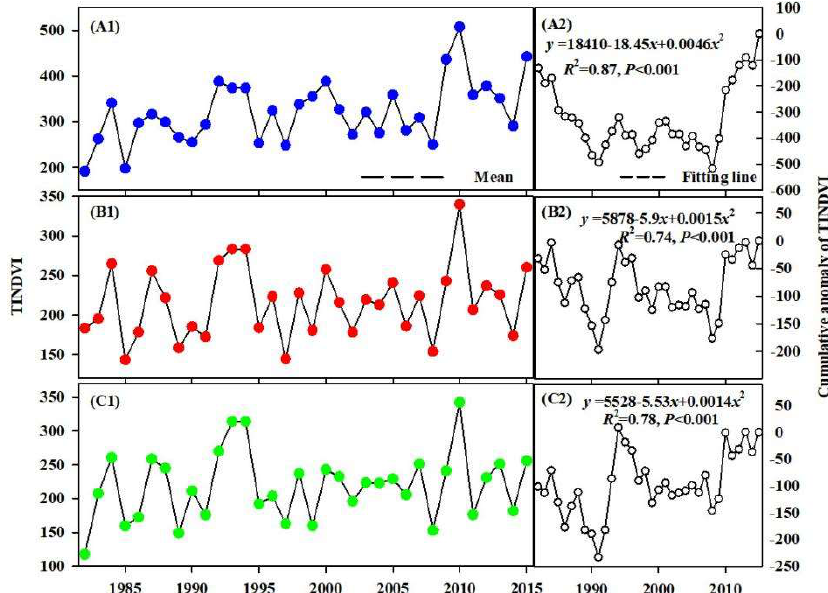
Figure 3. Interannual variation characteristics of TINDVI. ( A1 , B1 , C1 ) show the annual change of TINDVI in alpine, valley and desert. Meanwhile, ( A2 , B2 , C2 ) show the change of cumulative anomaly of TINDVI in alpine, valley and desert. The fitting line of the cumulative anomaly of TINDVI indicated that there was a significant increasing mutation in the alpine, valley and desert areas. The line of mean value showed a variation of TINDVI after mutation occurred.